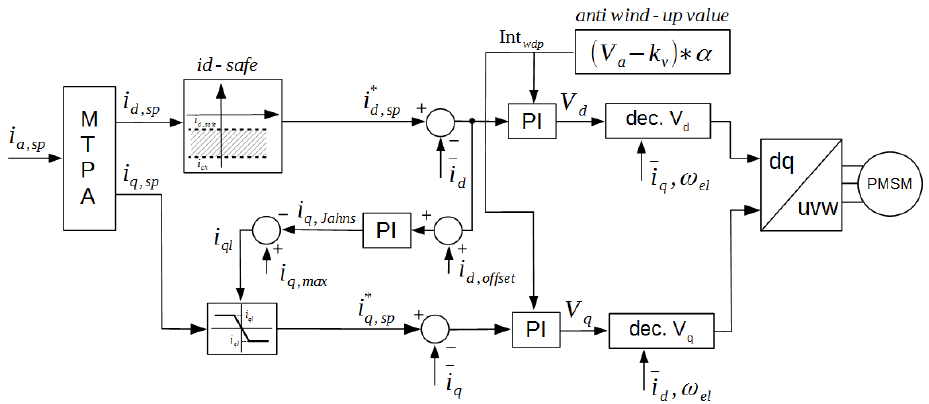
Figure 16. Proposed improved Jahns’ control